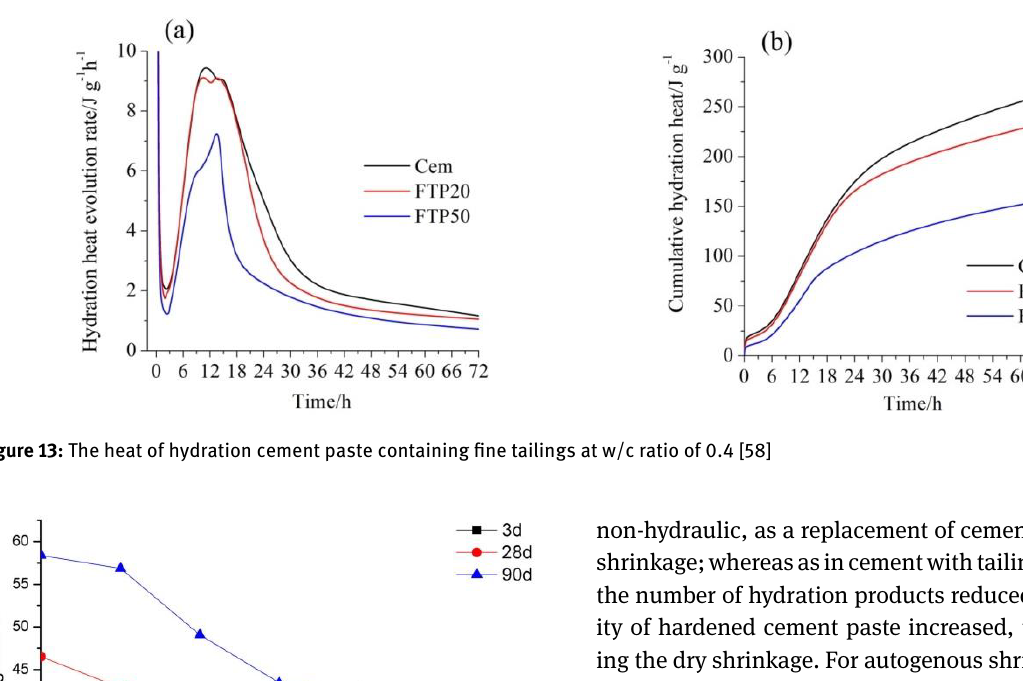
Figure 12: Cumulative heat (J/g of SCM) of untreated (dashed line) and treated (700 C, 30 min grinding) tailings. 2. Relation between mass loss under 650 C and increase in pozzolanic capacity, measured as cumulative heat release at 7 days [66]